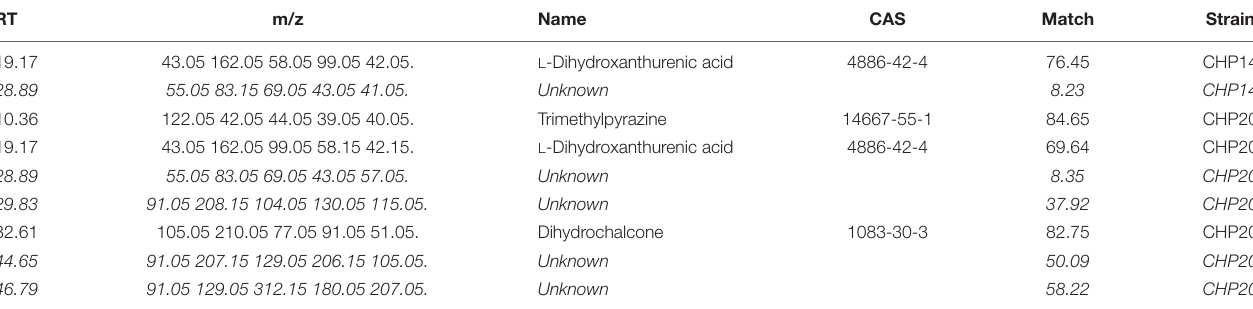
FIGURE 9 | Multivariate analysis of volatiles emitted by active vs. closely related non-active strains. Two dual strain comparisons are shown: (A) CHP14 vs. CHD4; (B) CHP20 vs. SOD6. Active strains are shown in red, inactive relatives in green. Principal component analysis (PCA) score plots are shown in the upper row. These PCA plots display data variance over two principle axes, with explanatory percentages shown in brackets. Volcano plots displaying significance over fold-change are shown in the lower row. Mass features varying with high significance ( p < 0.05) and fold-change ( > 2) are displayed in pink and framed red for features associated with active strains vs. green for those associated with inactive strains. TABLE 2 | Volatile compounds enriched in active strains, as revealed by multivariate analysis on log transformed, normalized GC/MS data using MetaboAnalyst 3.0. RT